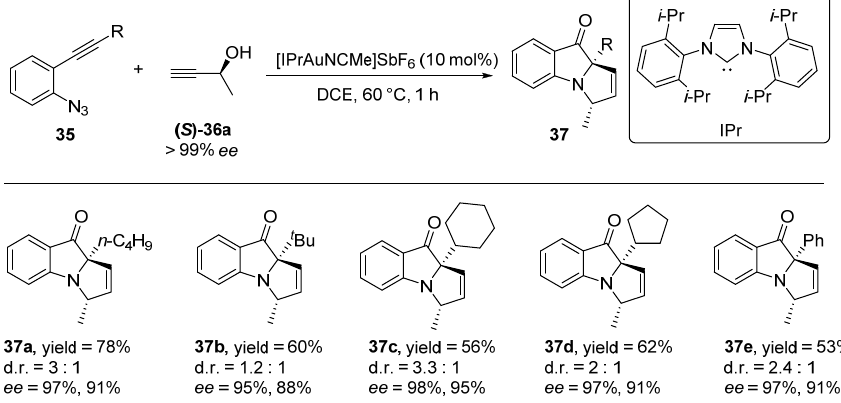
Scheme 20. Synthesis of chiral pyrroloindolone derivatives 37